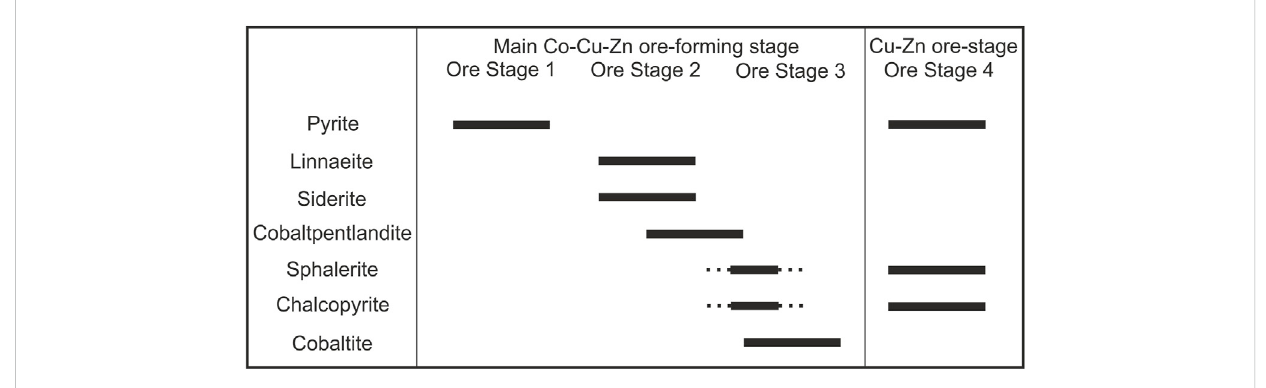
FIGURE 8 Revised paragenetic sequence of the main Co (-Cu-Zn) ore-forming stage of the DOF deposit, along with the later, secondary Cu-Zn stage (modi fi ed after Bertrandsson Erlandsson et al., 2022). See text for a more detailed description of the physiochemical conditions of each